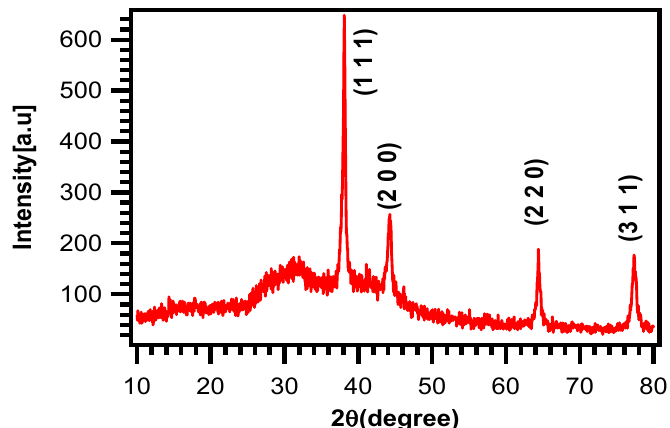
Figure 3. XRD pattern of biosynthesized AgNPs.